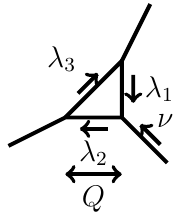
Figure 17 . A web-like description for the connecting three E 0 matter which is a 5d description of the ( 3) model. O (cid:0)